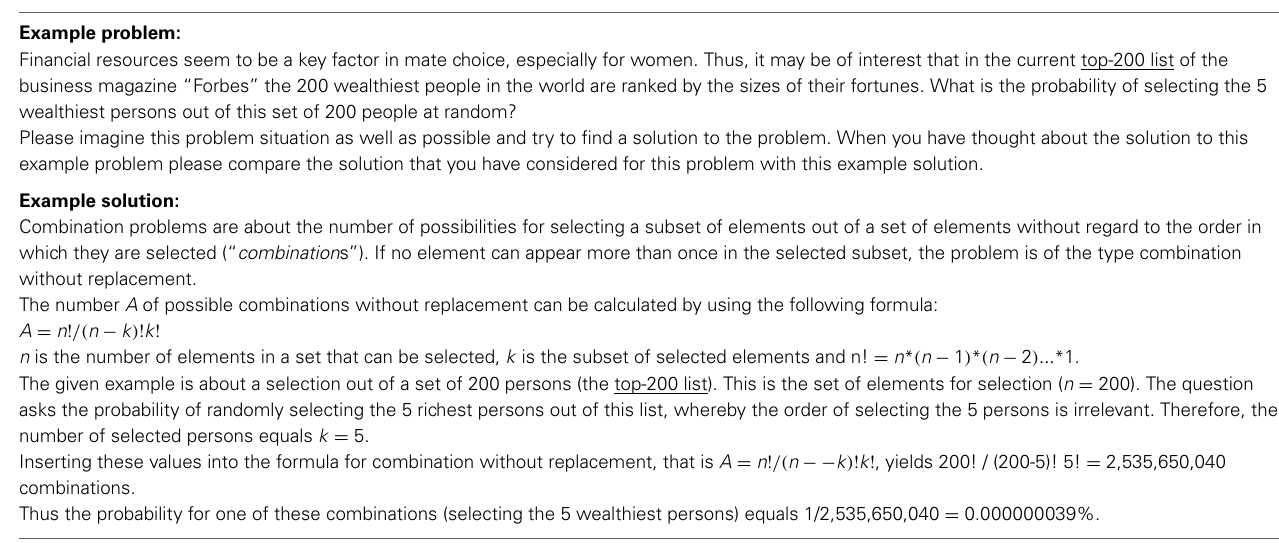
Table 2 | Worked-out example for the problem category “combination without